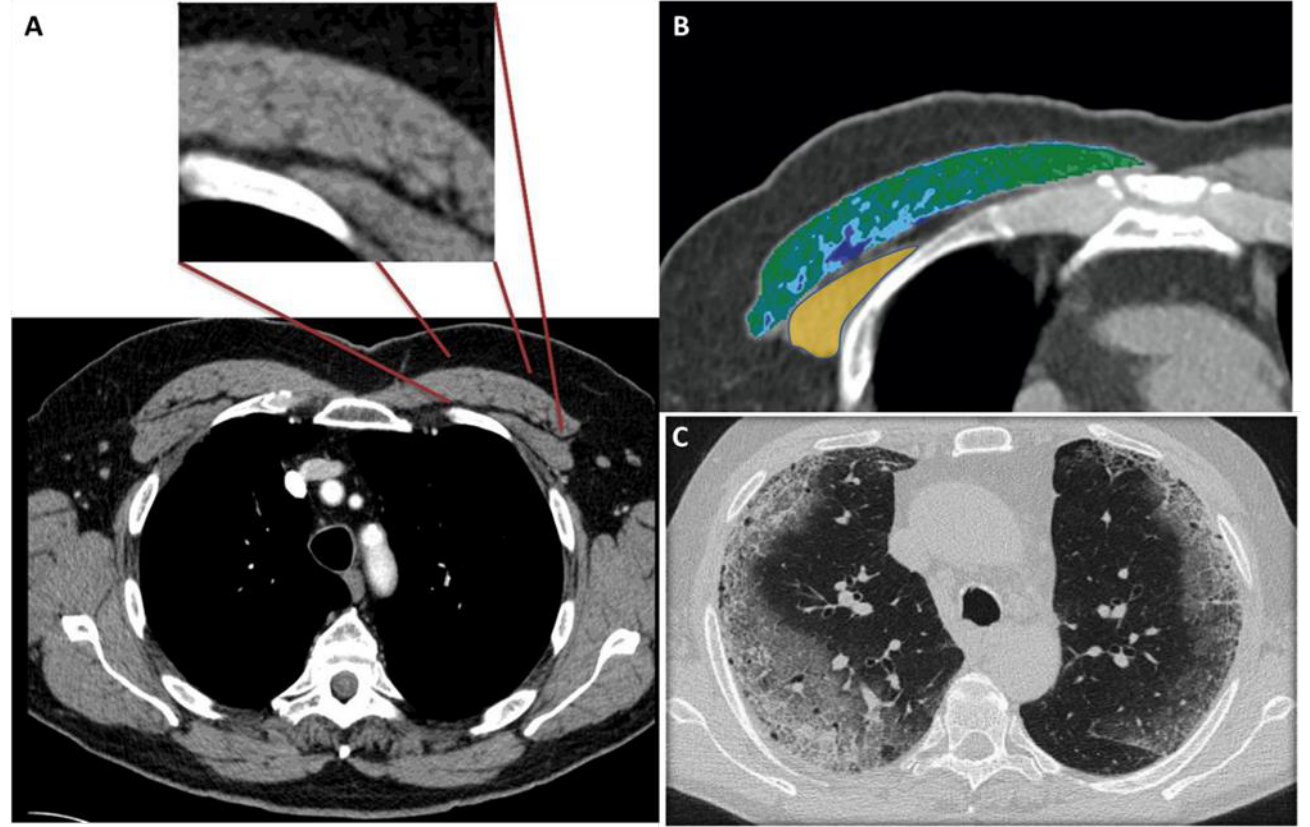
Figure 1 A-C 56-year-old male with COVID-19. Figure 1. ( A – C ) 56-year-old male with Figure 1A shows the CT-slice selection and the pectoral analysis. Figure 1B shows the pectoral muscle area (34.2 cm 2 ) and pectoral muscle density (30.2 HU) analysis of the pec- toralis major (green-blue area) and minor (yellow area). Figure 1C shows the correspond- ing lung disease (pneumonia severity index score: 7). The patient had a short ICU stay, and he had successful extubation. Figure 2 A-B 58-year-old female with COVID-19.